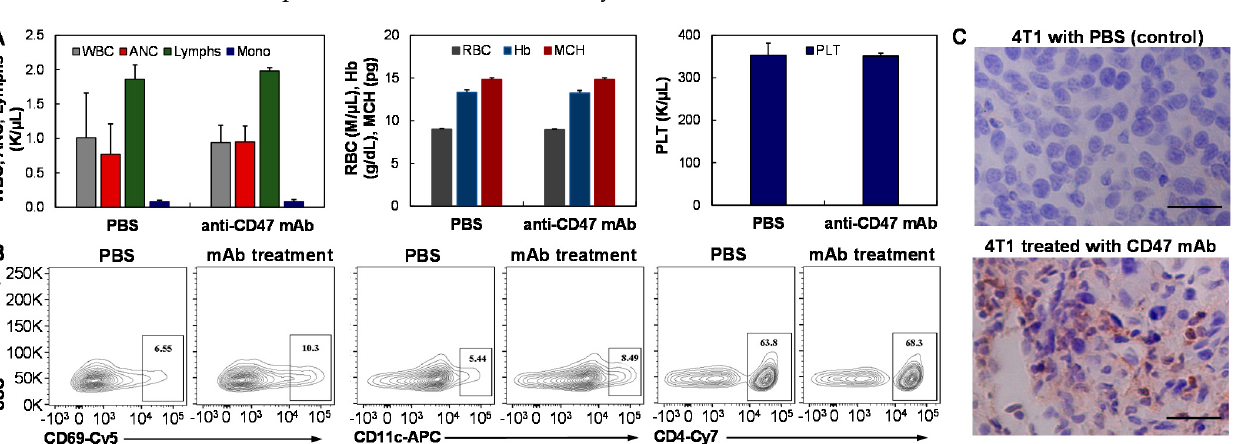
Figure 7. Immune response analysis of BALB/cJ mice post i.v. injection of anti-CD47 mAb. ( A ) Whole blood analysis showing minimal effect of anti-CD47 mAb on peripheral immunity. ( B ) Flow cytometry analysis of immune cells in lymph nodes indicating the increased level of CD69 + NK, CD11c + DC, and CD4 + T cells. ( C ) IHC staining of the 4T1 xenograft tumor demonstrating obvious macrophage infiltration and phagocytosis in the tumor microenvironment.